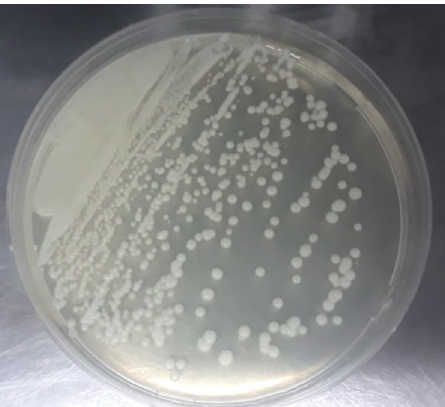
Figure 1: Macroscopic appearance of the Candida species on the sabouraud chloramphenicol culture medium.